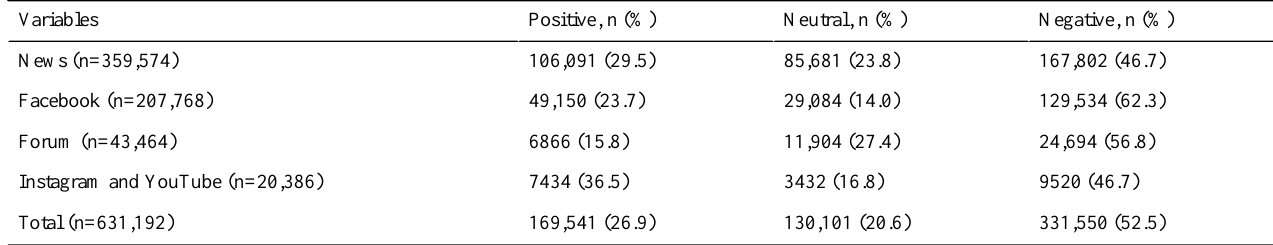
Table 3. Sentiment assessment of stigmatizing terms by media